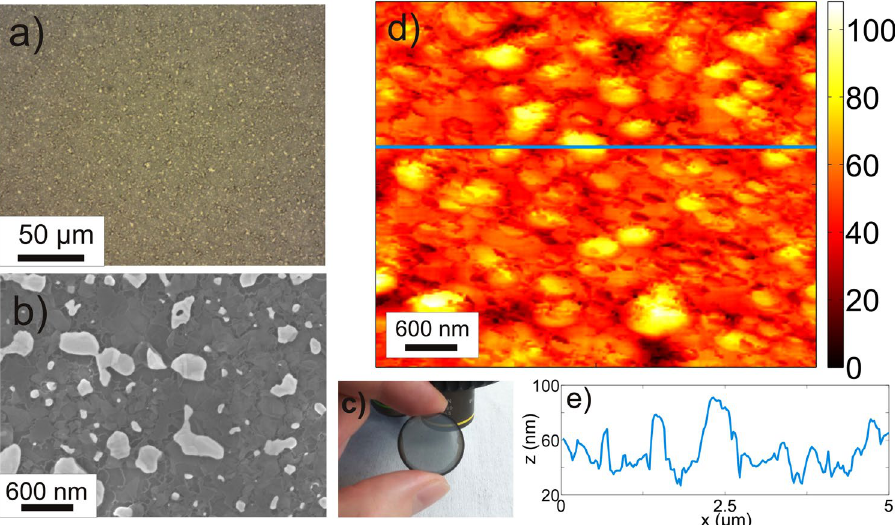
Figure 2. Optical microscope ( a ) and scanning electron microscope (SEM) ( b ) images of the PPF + Ni film show the Ni particles on a sample surface. ( c ) Photographic image of the semitransparent PPF + Ni. ( d ) An atomic force microscopic image shows that the height of the largest Ni particles is around 100 nm. ( e ) The film thickness plotted along the blue line shown in ( d